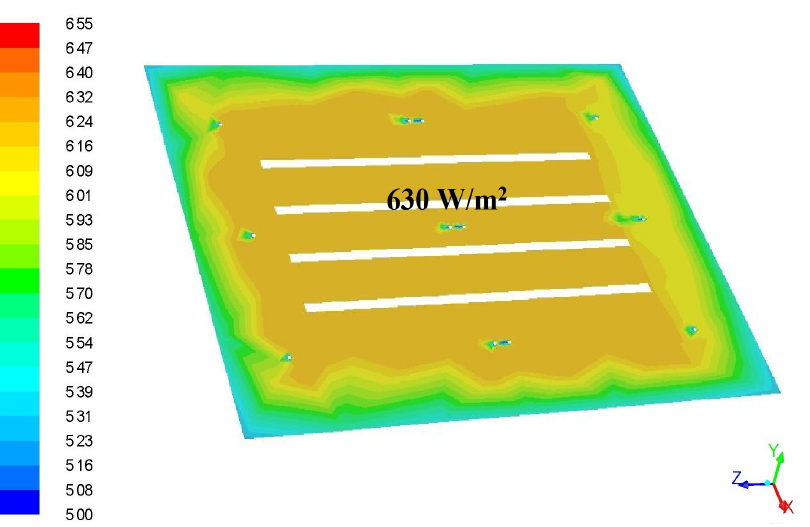
Figure 8. Simulated solar flux received at the indoor ground level of the greenhouse at solar noon.